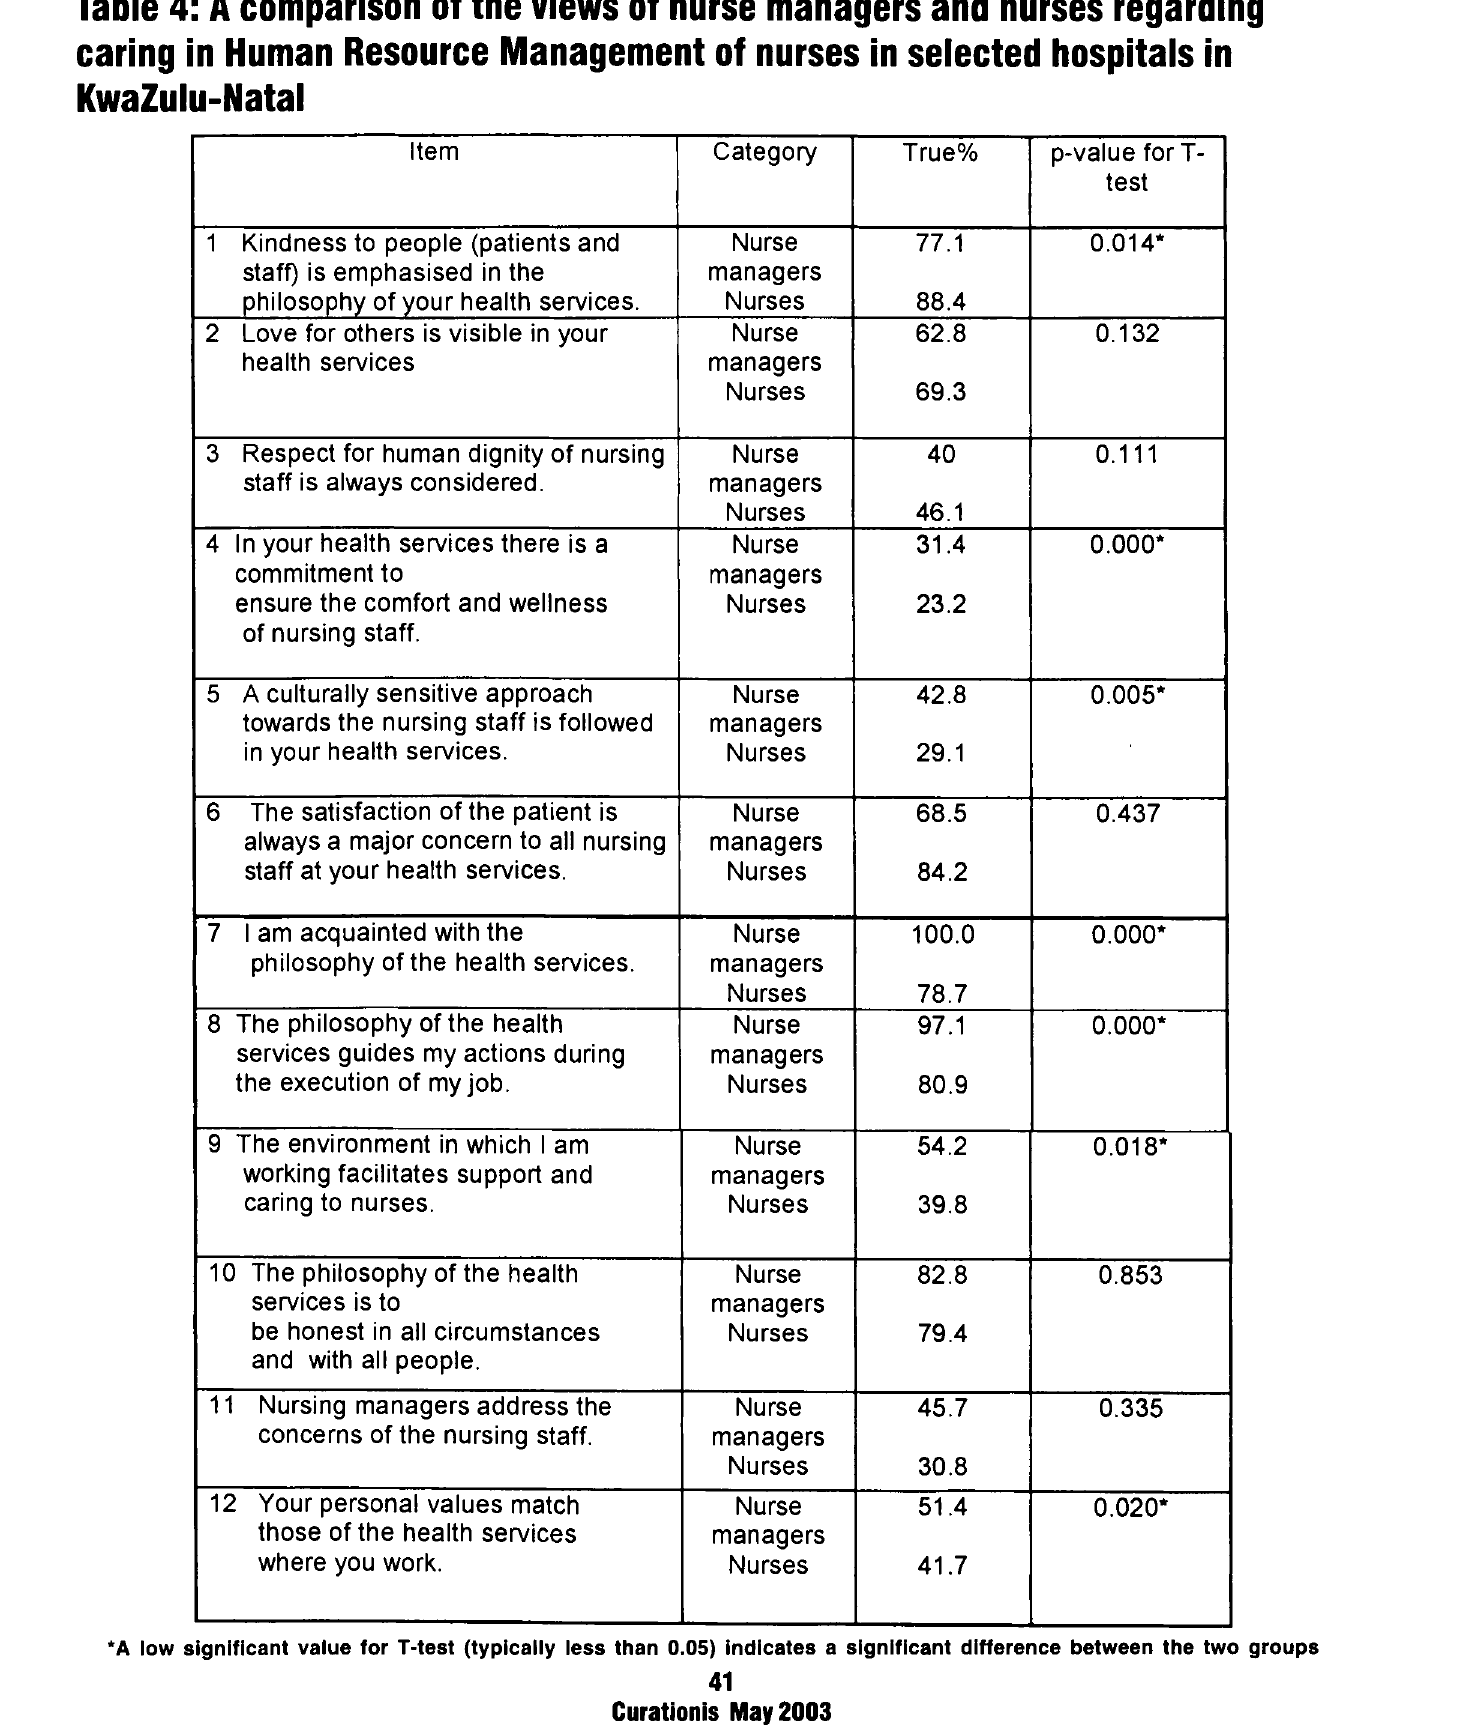
Table 4: A comparison of the views of nurse managers and nurses regarding caring in Human Resource iVlanagement of nurses in selected hospitals in KwaZulu-Natal Item Category T rue% p-value forT-